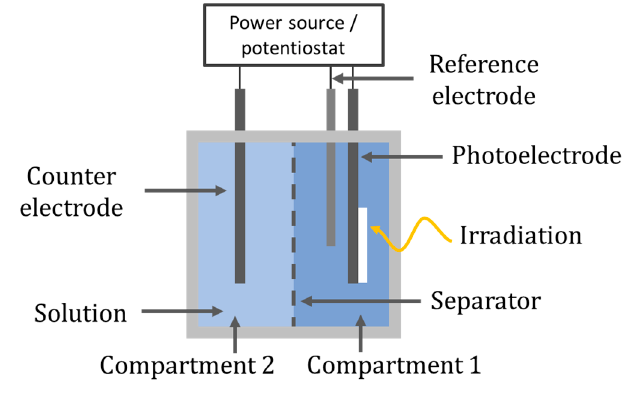
Figure 23. Two-compartment reactor set-up.